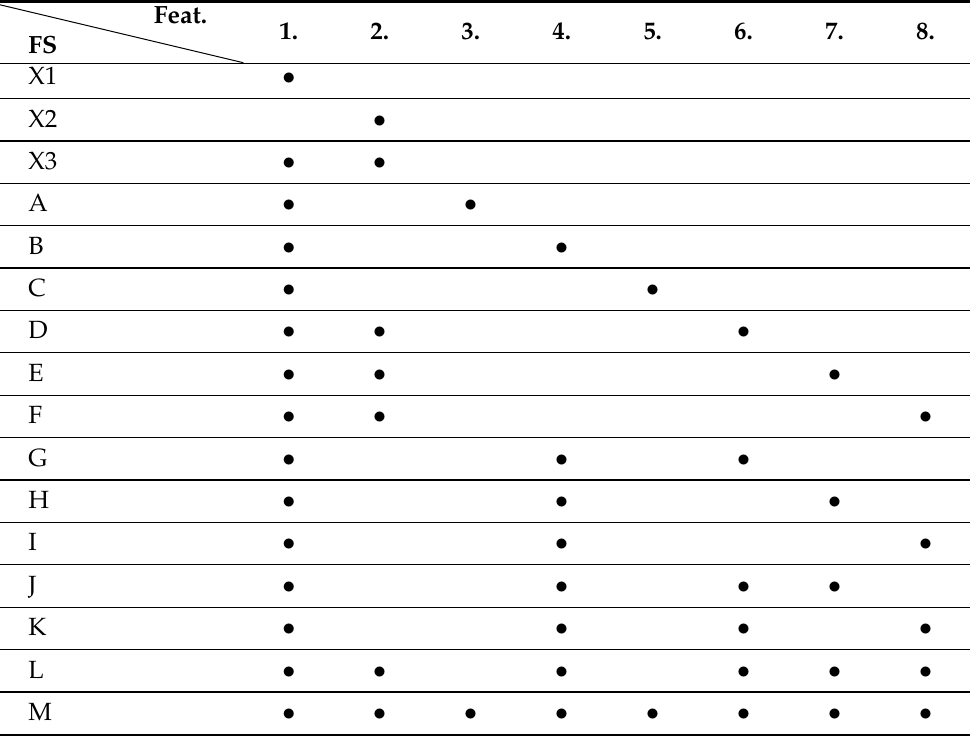
Table 5. Overview of feature subsets (FS) used in experiments. Bullet depicts that the feature is in the